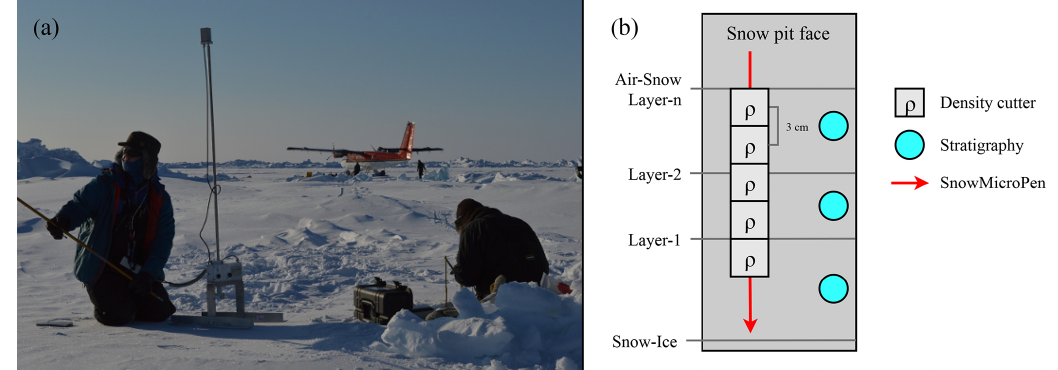
Figure 2. Photo of typical SMP and snow pit measurements on MYI (a) and sketch of the sampling procedure (b) . Manual density measure- ments (3cm height) were collected as continuous profiles between the air–snow and snow–ice interfaces (IF). SMP profiles were compiled 10cm behind the pit face at each site. A rigid mount was used to stabilize the SMP while penetrating hard surface slabs (a) . Table 2. Model coefficients for Eq. (1) as originally defined in Proksch et al. (2015; P15) and recalibrated as part of this study to estimate snow density sea ice (K20). Regression coefficients Metrics